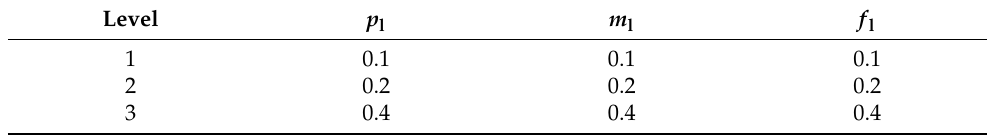
Table 7. Orthogonal test levels under complex loads.